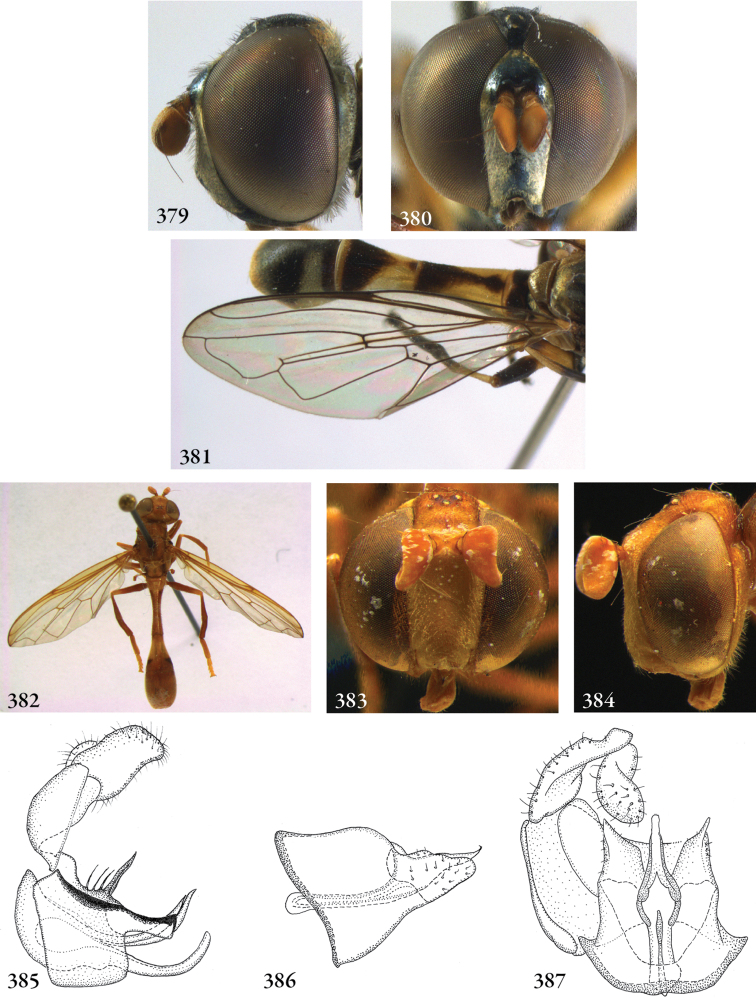
379–381
Spheginobaccha macropoda male (Vietnam, coll. RMNH): 379 head lateral 380 head frontal 381 wing 382–384
Spheginobaccha guttula male (holotype): 382 habitus dorsal 383 head frontal 384 head lateral 385–387
Spheginobaccha, male genitalia: 385
Spheginobaccha macropoda (Vietnam, coll. RMNH), lateral 386
Spheginobaccha guttula (holotype), hypandrium, including aedeagus, lateral 387
Spheginobaccha guttula (holotype), ventral.